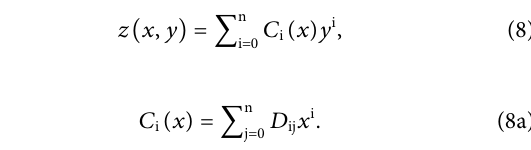
TABLE 14 | Maximum absolute error between the two quick calculation methods and the standard data. Physical quantity AE max of the fi tted T ( h , p